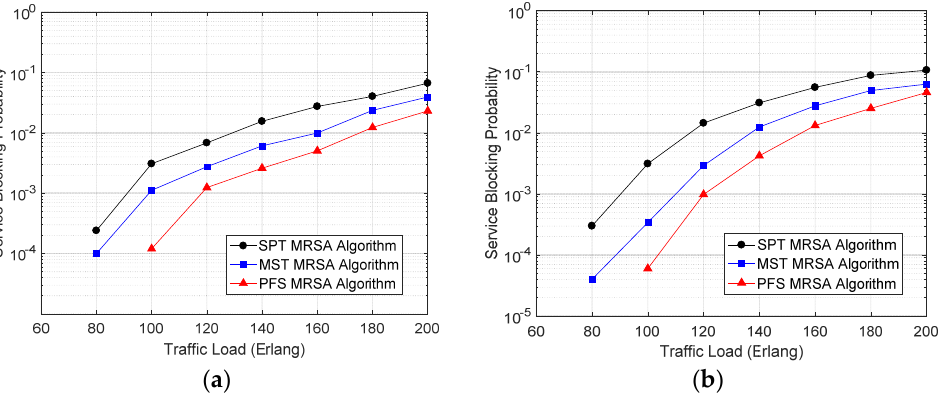
Figure 6. Simulation results on service blocking probability in different network architectures under scenario two: ( a ) in NSFNET and ( b ) in USNET.